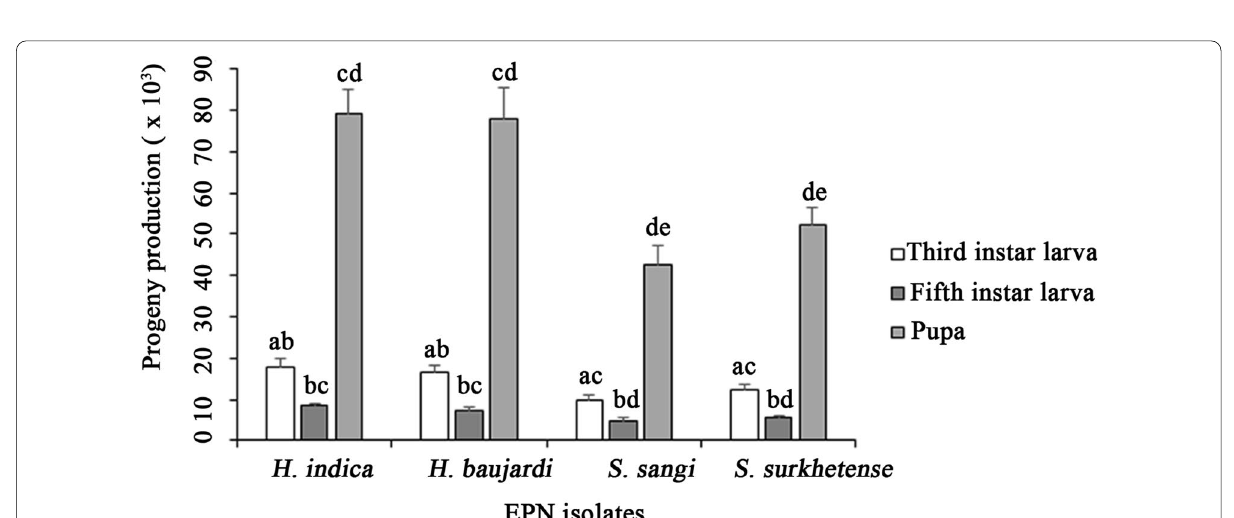
Fig. 6 Progeny production of the studied EPN isolates on 3rd, 5th larval instars and pupae of Spodoptera